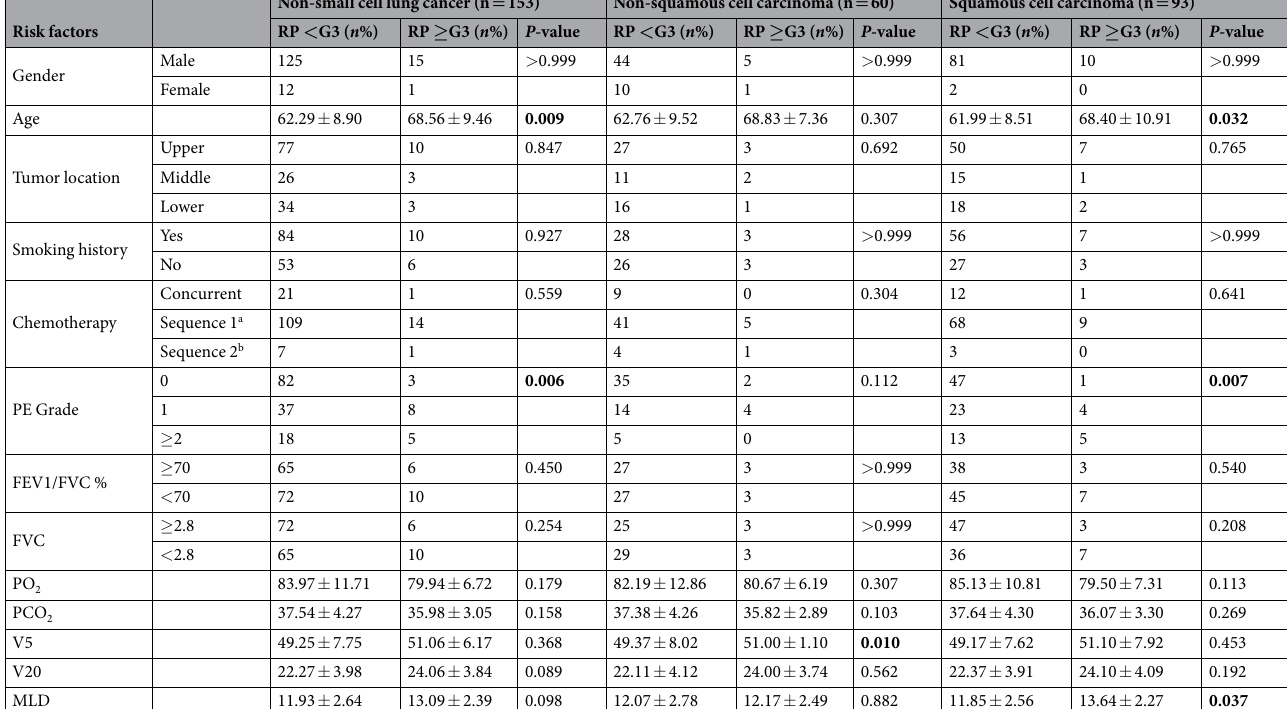
Table 3. Univariate analysis of possible risk factors associated with the development of Grade ≥ 3 RP. RP: radiation pneumonitis; G2, grade 2; G3, grade 3; PE, pulmonary emphysema; FEV1, forced expiratory volume in one second; FVC, forced vital capacity; PO 2 , arterial partial pressure of oxygen; PCO 2 , arterial partial pressure of carbon dioxide; V5, V20, the percentages of pulmonary volume irradiation exceeding 5 Gy, 20 Gy; MLD, mean lung dose. a Sequence 1, patients who received chemotherapy first. b Sequence 2, patients who received radiation therapy first. Significant differences are indicated in bold.